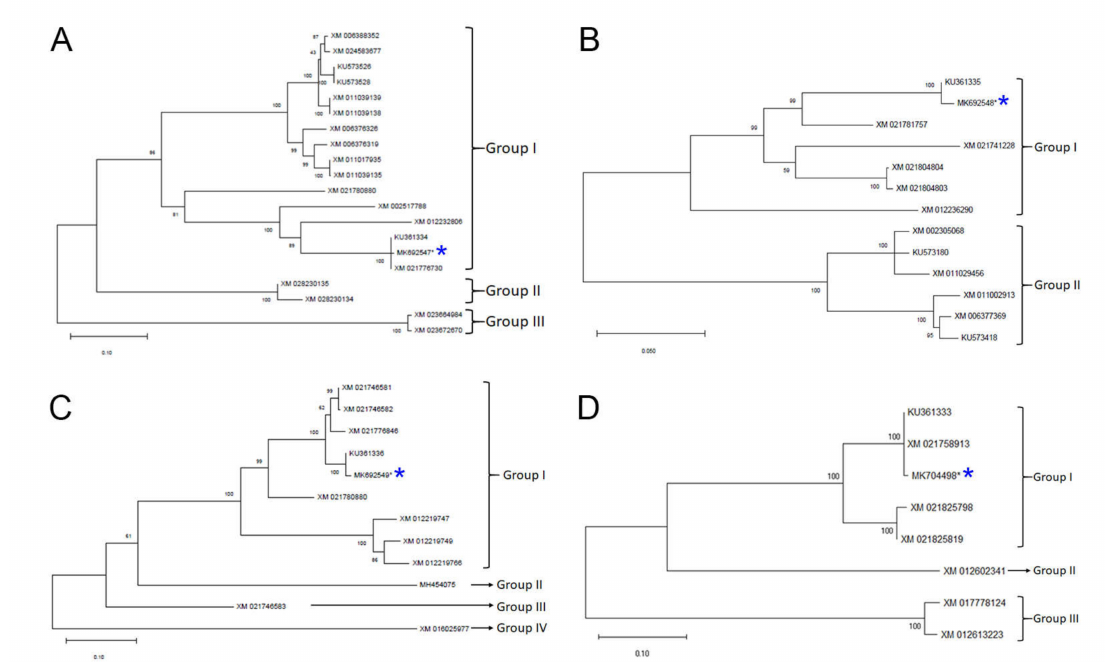
Figure 6. The rectangular form of a phylogenetic tree of a ( A ) ASMT1 , ( B ) ASMT2 , ( C ) ASMT3 , and ( D ) T5H genes sequence produced by the maximum likelihood algorithm under the assumption of T92 (Tamura 3-parameter) substitution model coupled to a discrete gamma distribution ( + G) and an assumed certain fraction of sites that are an evolutionarily invariable ( + I) option of the MEGA-X version 10.0.5 software (Kumar et al., 2018). Three major groups were delineated. The numbers above the branches indicate the bootstrap confidence value. The scale bar shows the number of substitutions per nucleotide. The blue asterisk indicates the sequence amplified from Arachis hypogaea